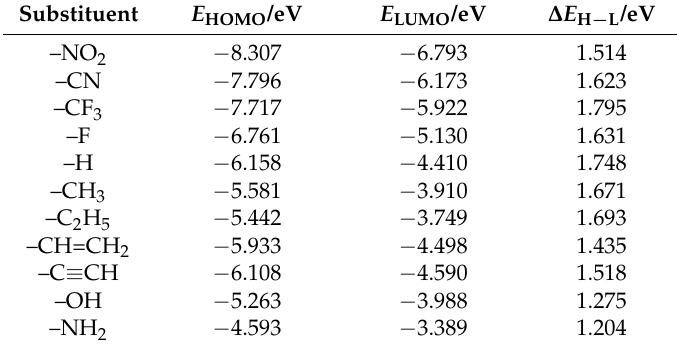
Table 1. The energies, the energy gaps between highest occupied molecular orbital (HOMO) and lowest unoccupied molecular orbital (LUMO), the λ hole and λ electron for Ni(S 2 C 2 R 2 ) 2 . (R=–NO 2 ,